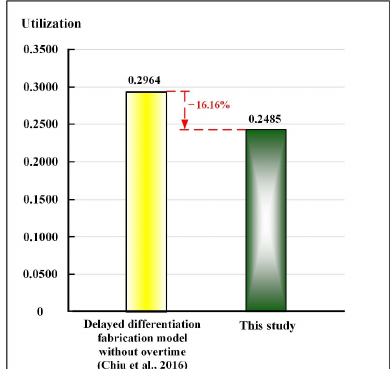
Fig. 19. Comparison of this study’s utilization with an existing work without